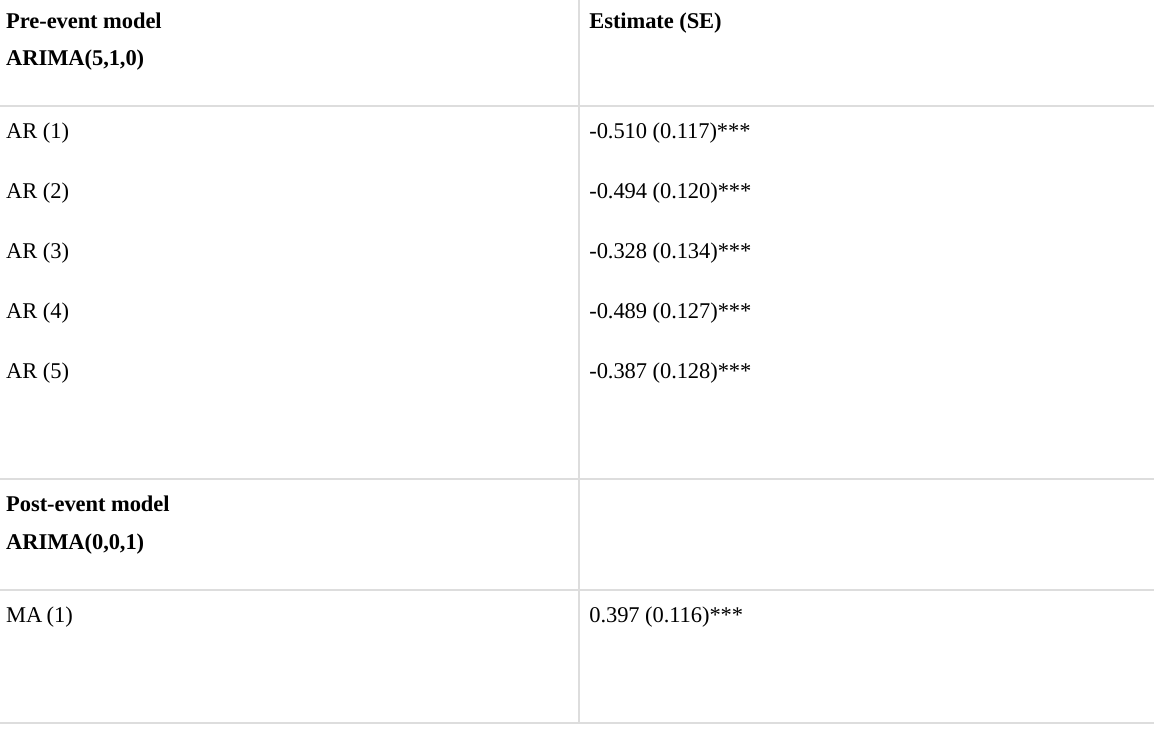
Table A2b. Goodness of fit measures of ARIMA models for vaccine